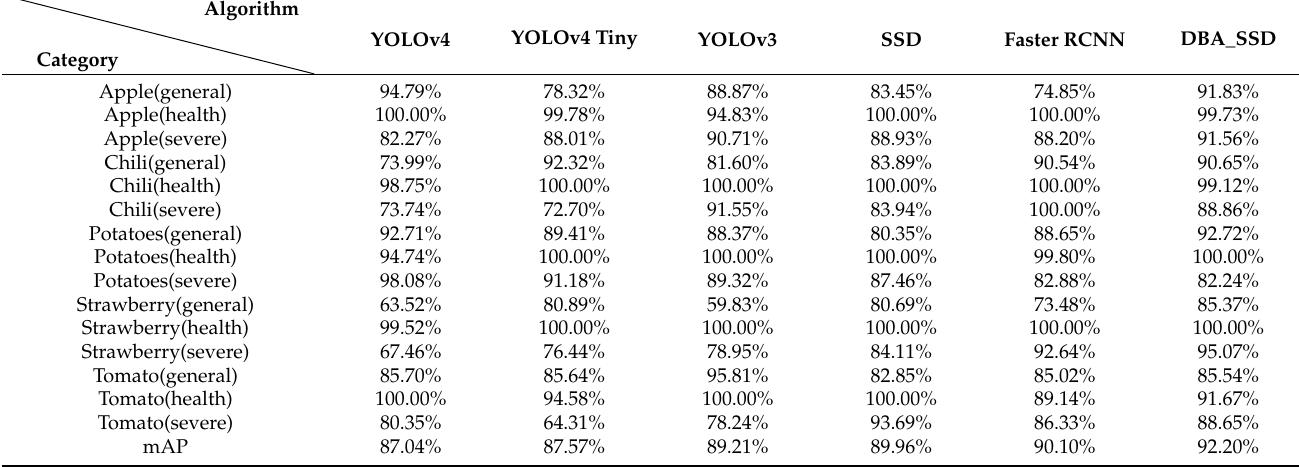
Table 3. Comparison of the accuracy of the improved SSD model and other target detection algorithms for the detection of different kinds of